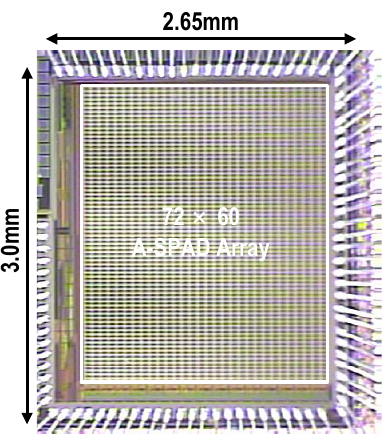
Figure 10. Micro photograph of the A-SPAD FLIM IC.